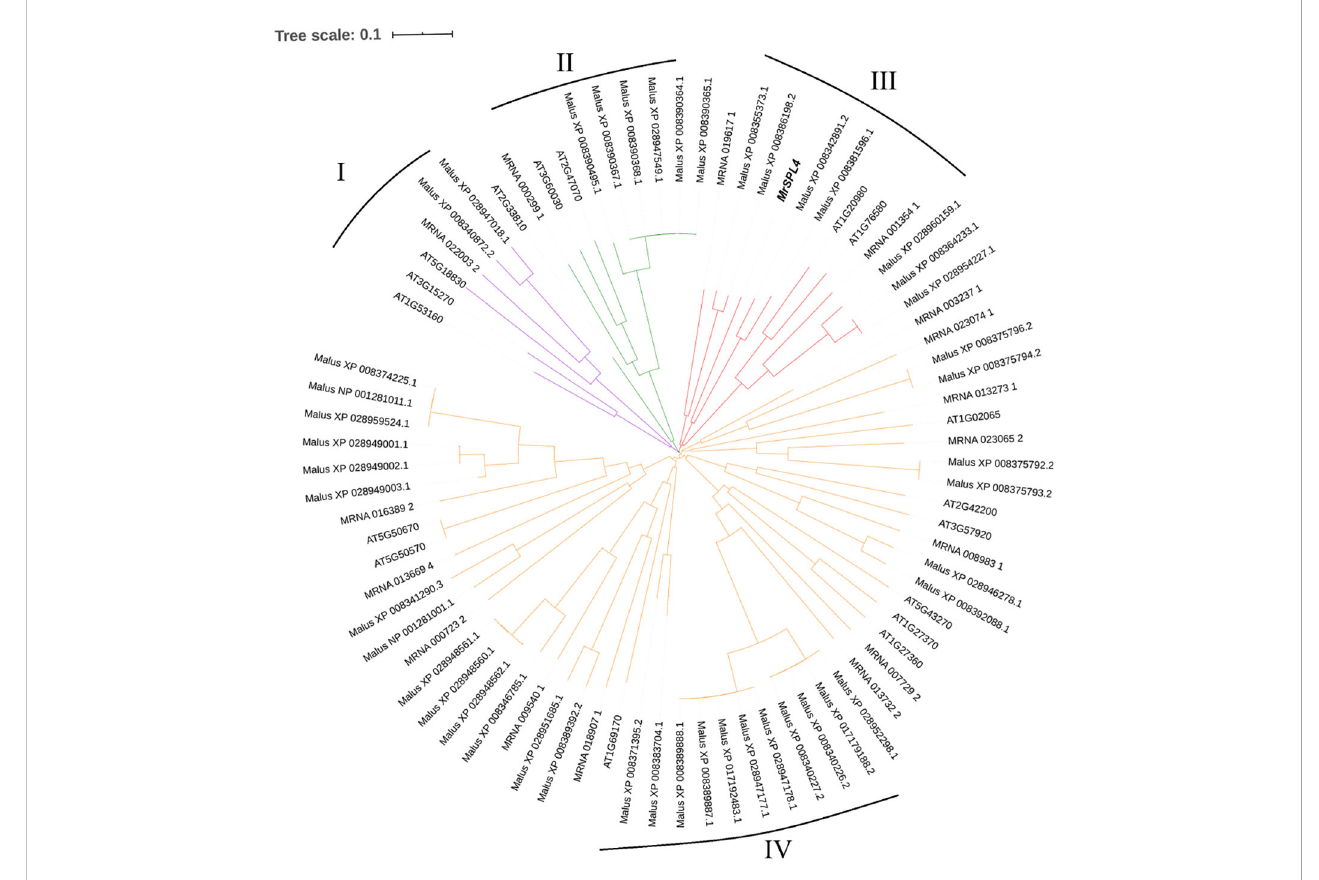
FIGURE 3 Evolutionary analysis of the SPL family gene in Myrica rubra and other